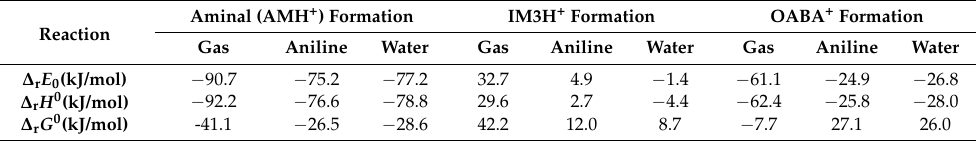
Table 4. Thermochemical properties for some side reactions of the formation of 4,4 (cid:48) -MDAH + .